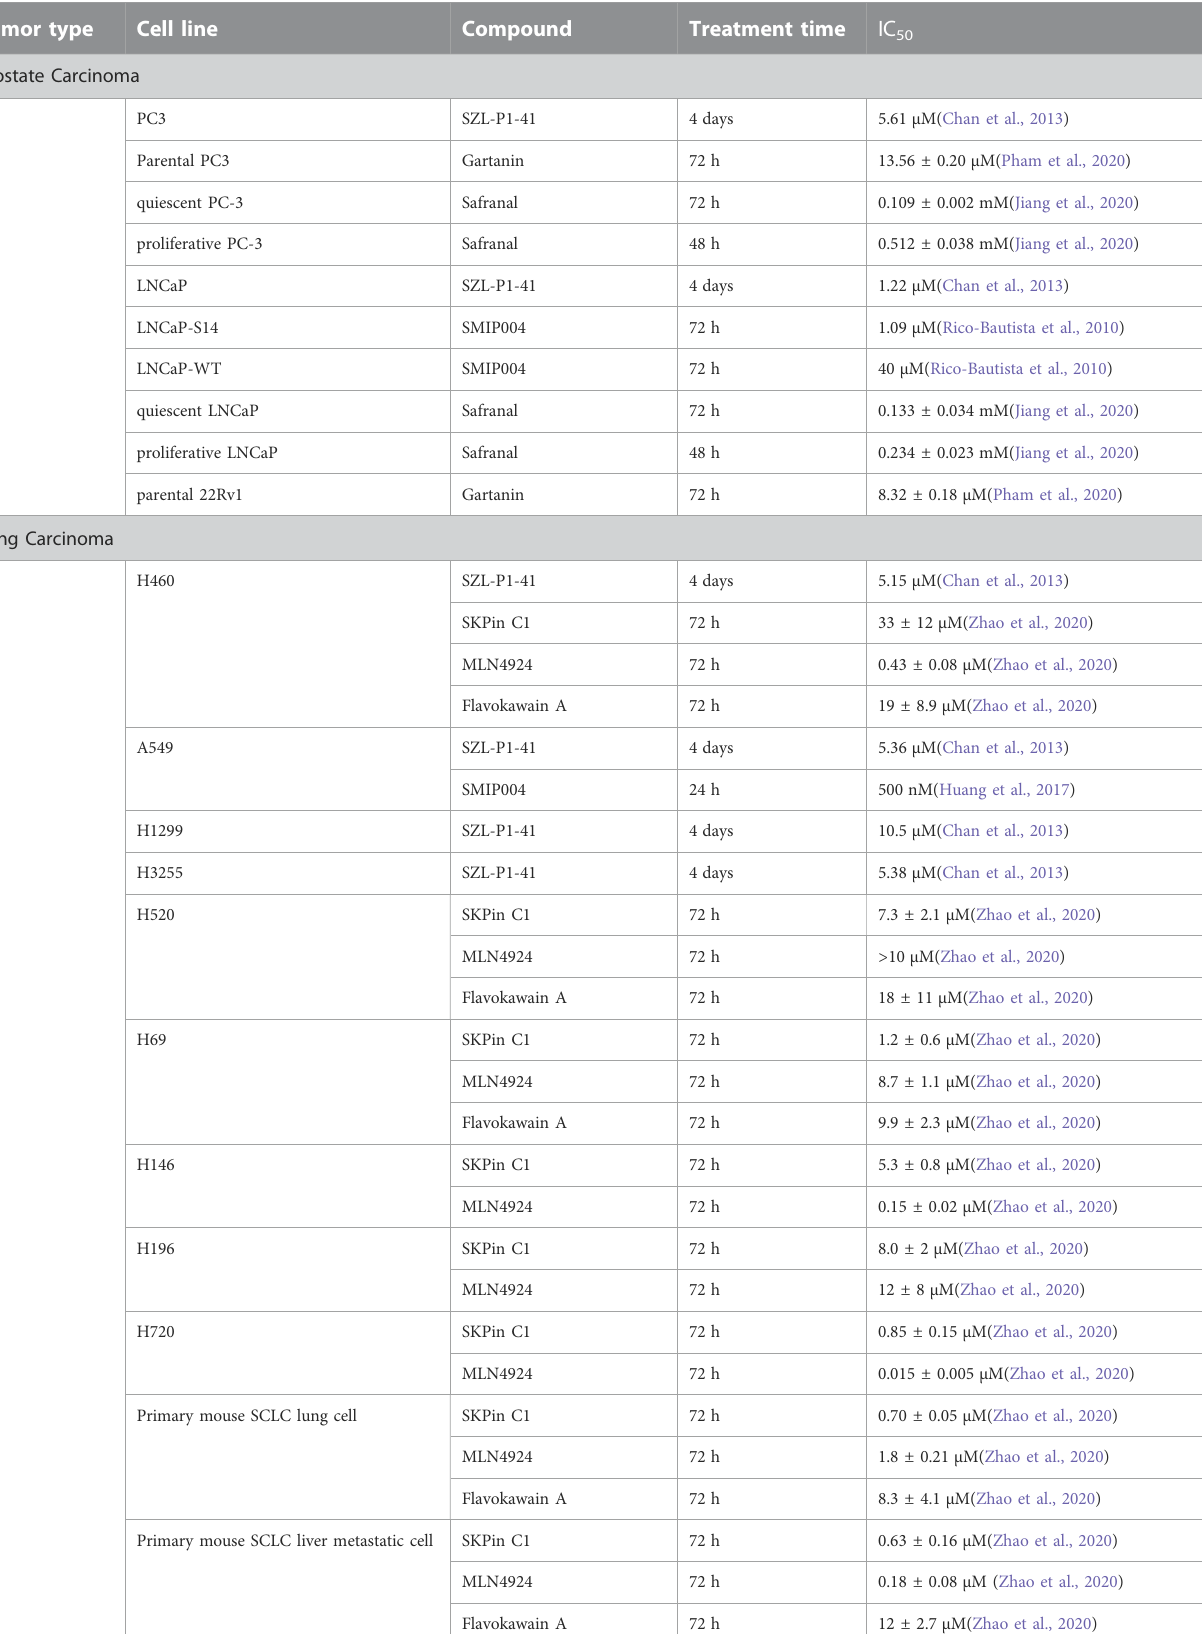
TABLE 2 Inhibitory effects of the Skp2 inhibitors or inhibiting compounds in various kinds of tumors at cellular level. Tumor